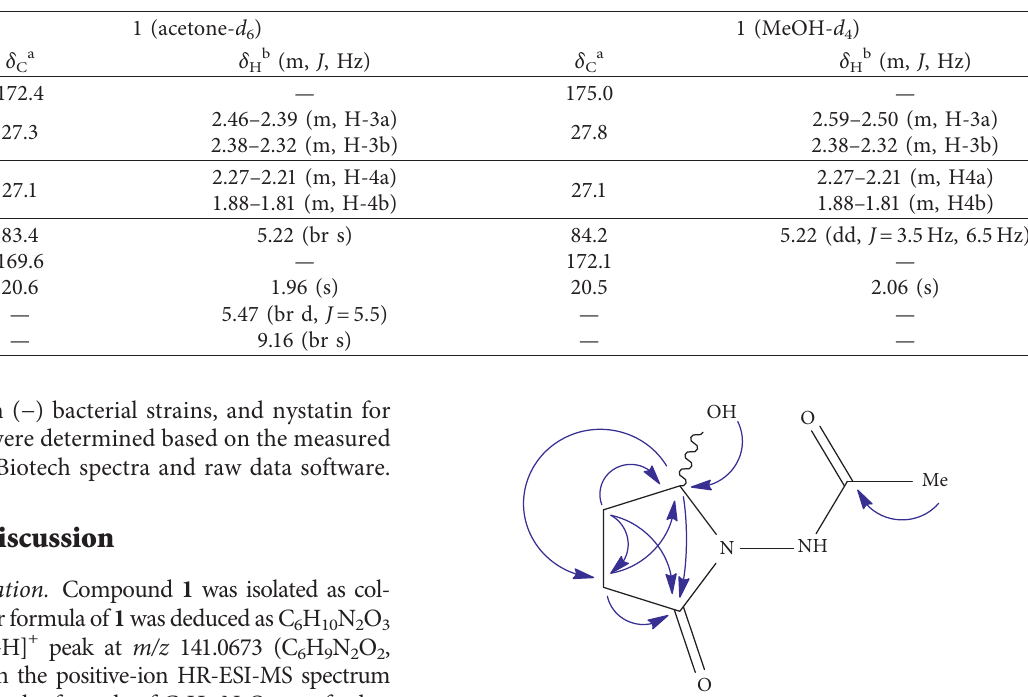
Table 1: 1 H and 13 C NMR data of 1 .